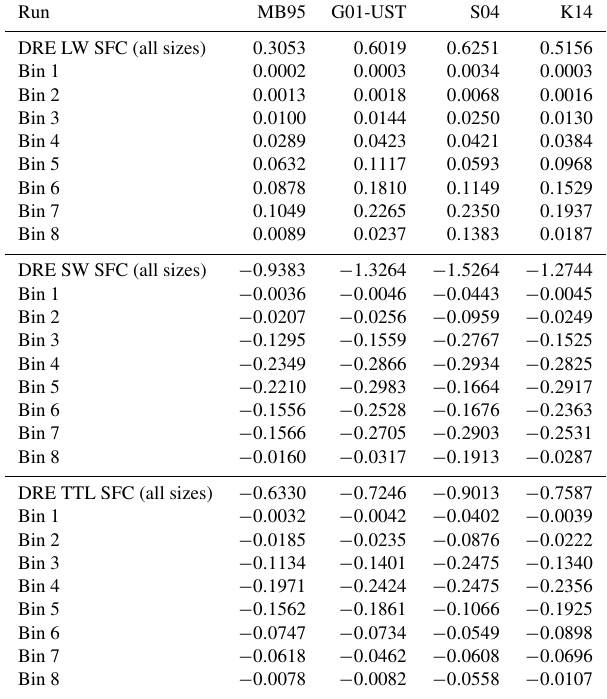
Table D1. Global averages of MONARCH-derived DRE [Wm − 2 ] (all particle sizes and relative contribution per bin) for each run at the SFC and TOA for shortwave and longwave radiation and the total (shortwave and longwave). Results are visualized in Fig. 11. The diameter ranges and effective radii of each bin are given in, respectively, Sect. 3 and Table